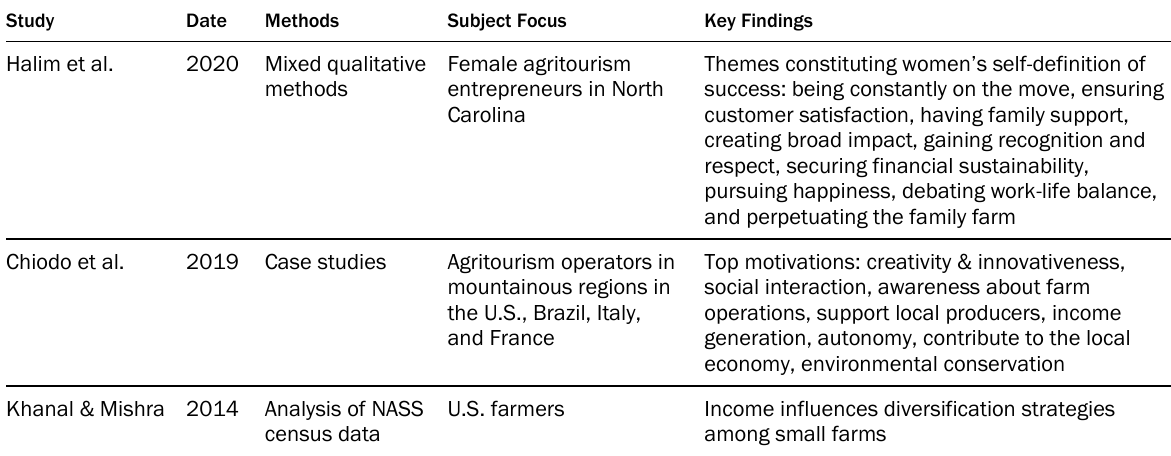
Table 1. Recent Literature on Agritourism Operator Motivations and Goals in the